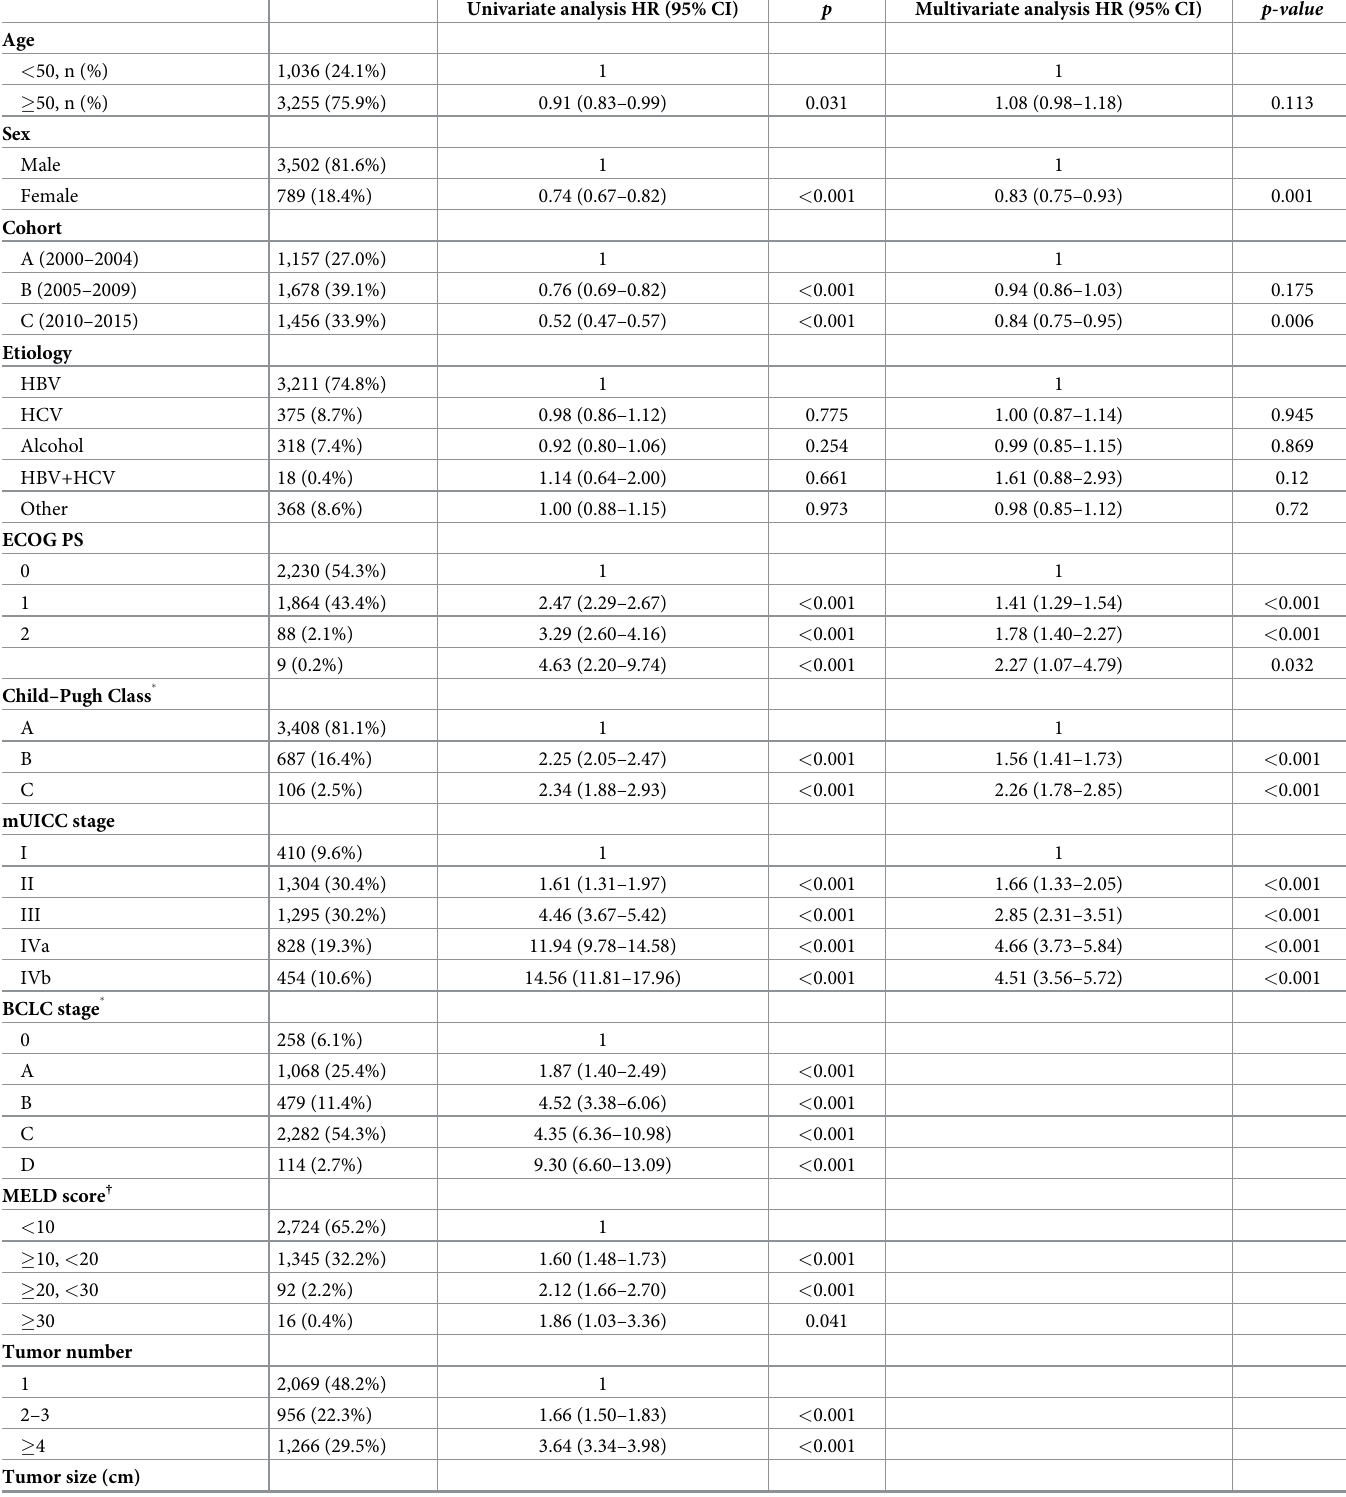
Table 2. Factors associated with overall survival in entire